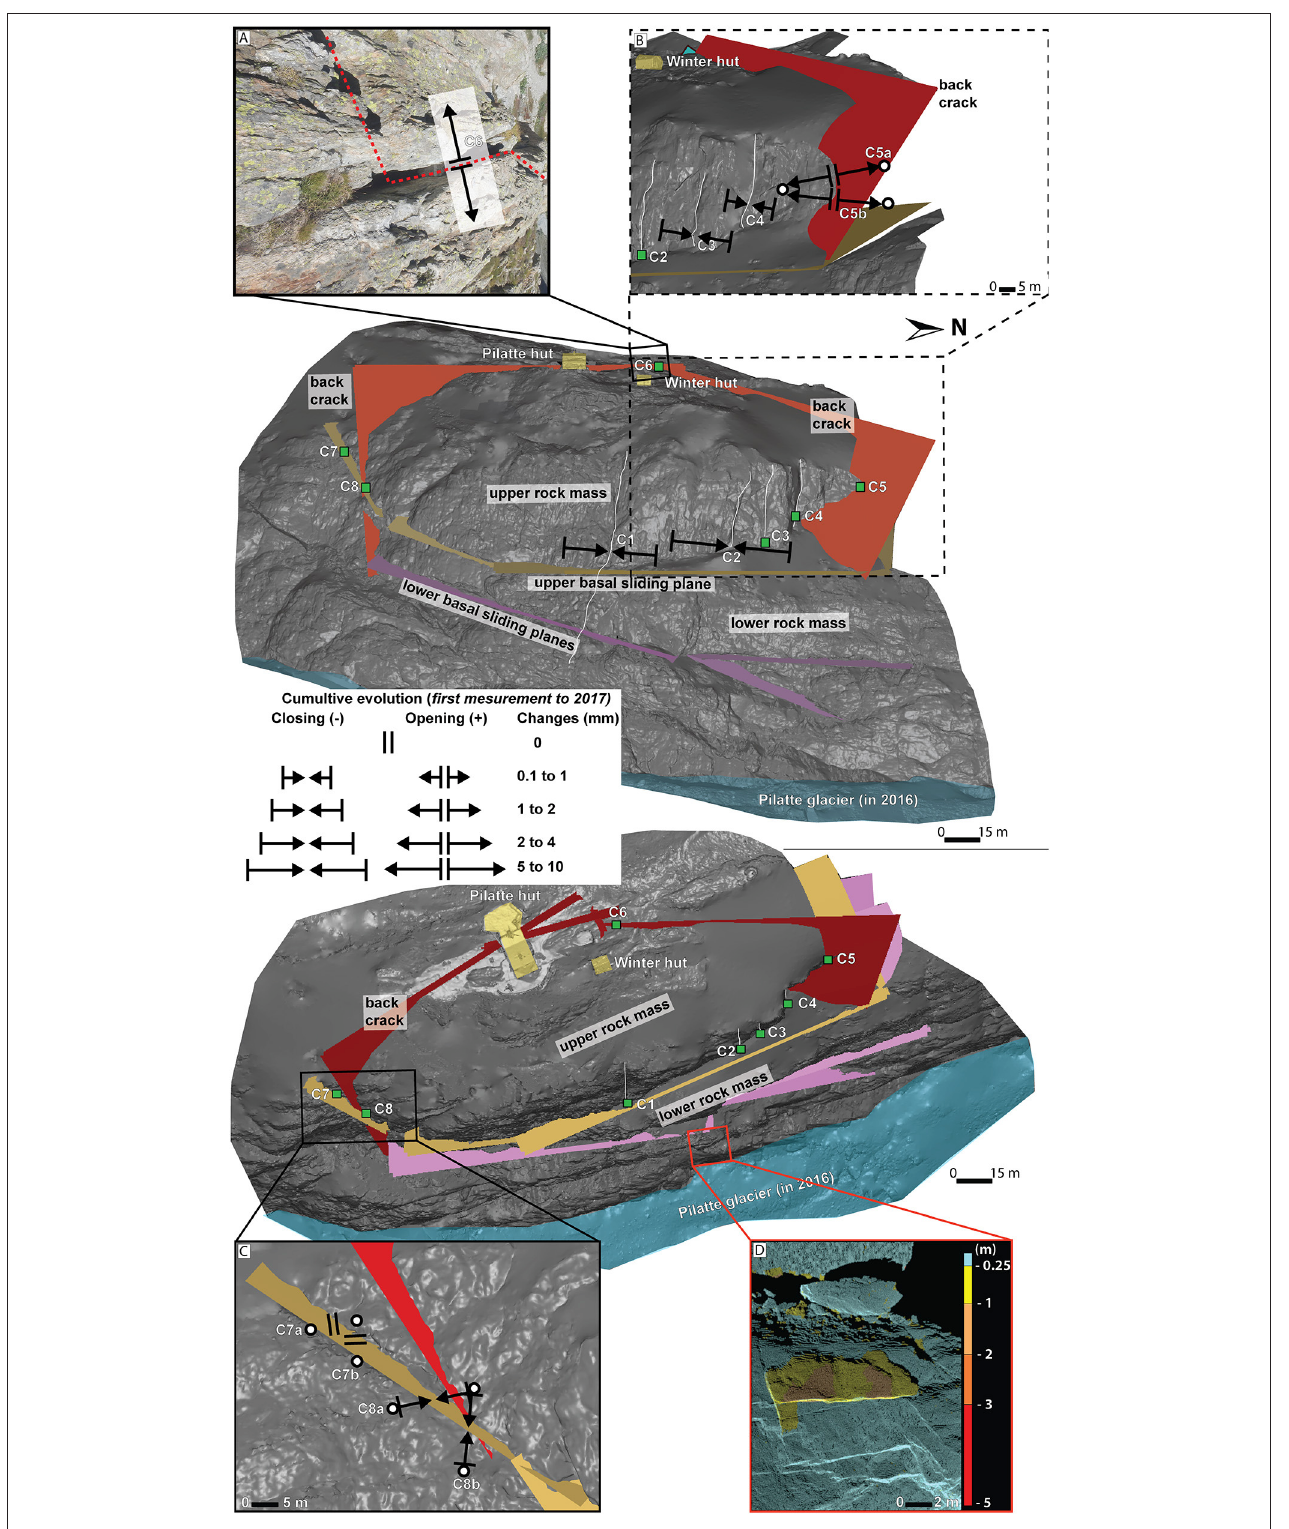
FIGURE 5 | Delimitation of the unstable rock mass and evolution of the monitored fracture lines over the period 2011–2017. View from the glacier (A,B) and aerial view (C,D) . D: rockfall detected when comparing the TLS 3D models of 2014 and 2016.